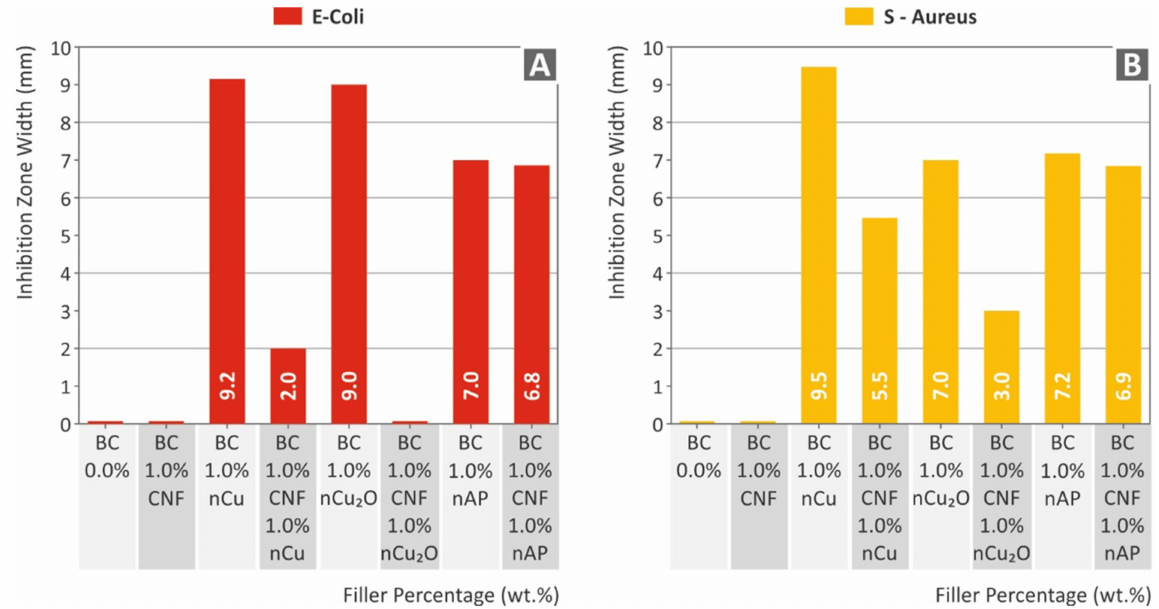
Figure 14. Comparison of the inhibition zone measurements for each material examined: ( A ) gram- negative E. coli ; ( B ) gram-positive S. Aureus